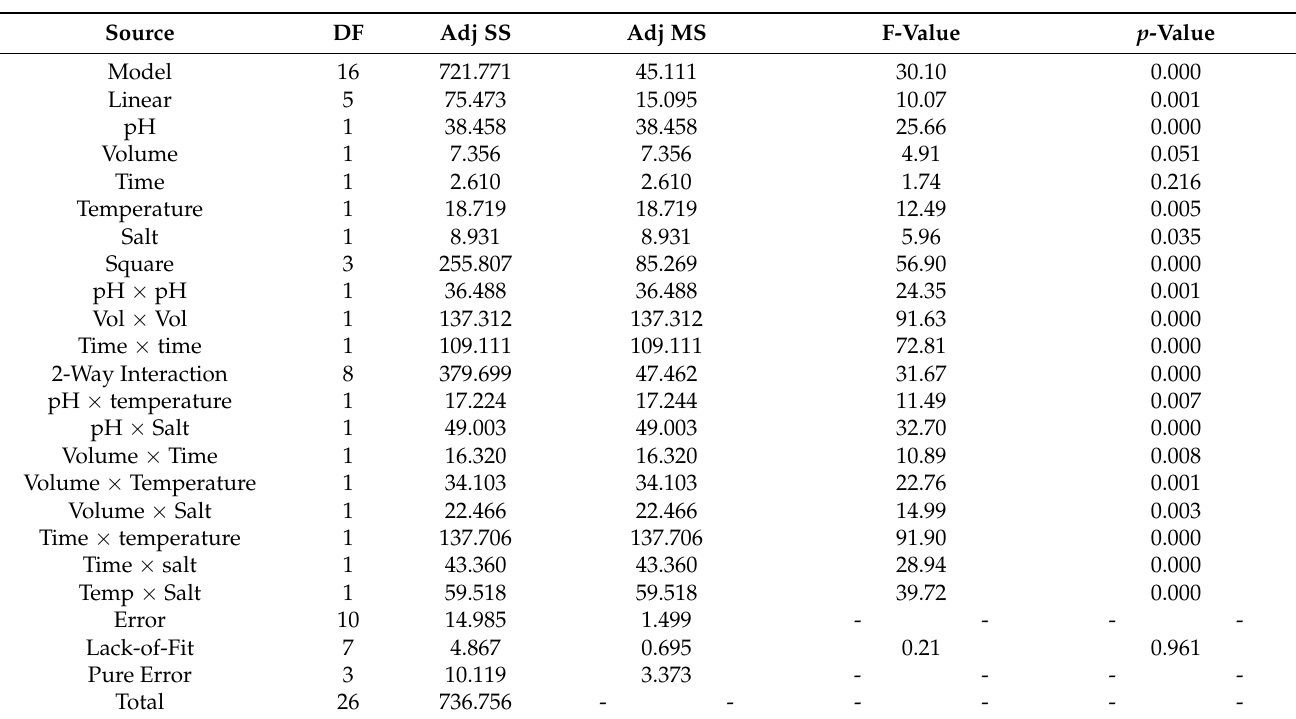
Table 3. Central composite design for optimization of dyeing variables using irradiated extract of red